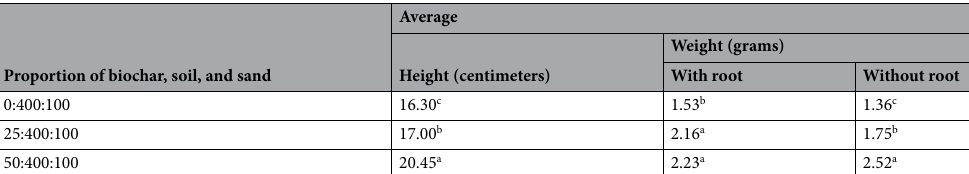
Table 4. Average shoot height and weight of plants grown in soil mixtures containing different proportions of biochar, soil collected from Klong 4, 5, and 6, and sand. We performed the measurement after 23 days of cultivation (different lowercase letters in the column indicate significant differences at the P < 0.05 level following two-way ANOVA analysis and DMR test).